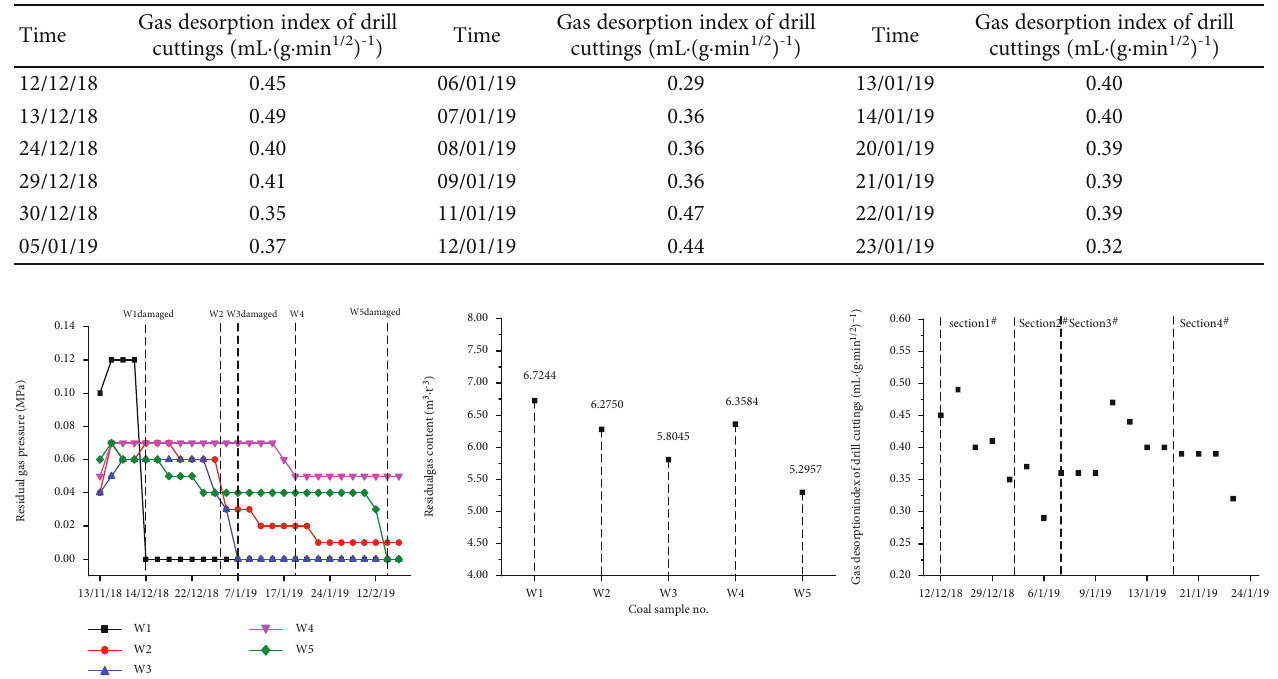
Table 11: Monitoring results of the residual gas pressure gas desorption index of drill cuttings.